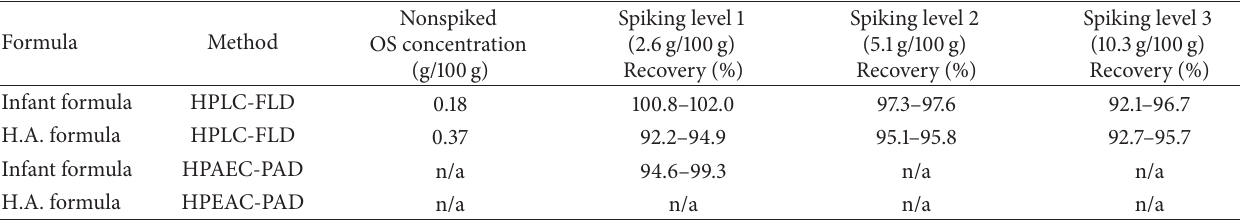
Table 2: GOS recovery measured in spiked infant formulae.